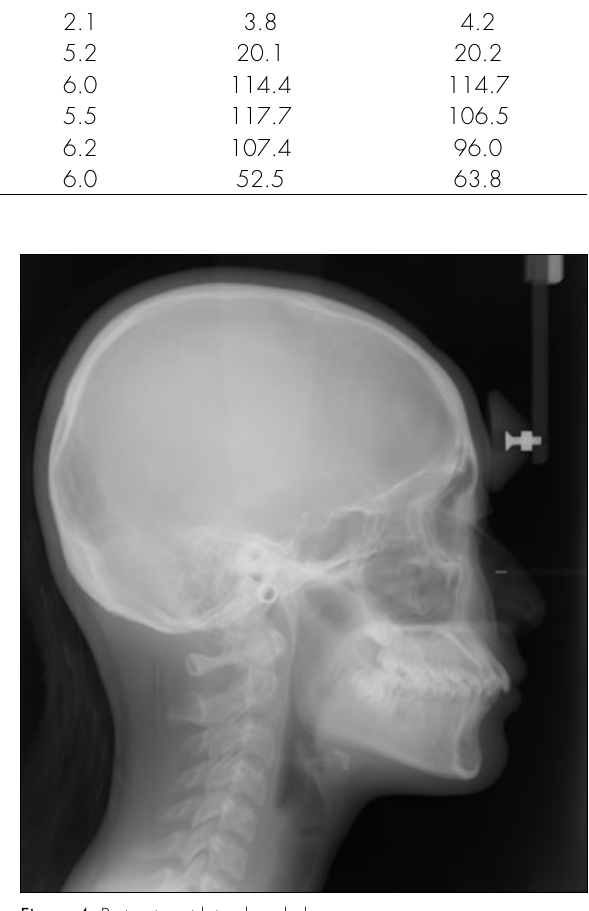
Figure 4. Pretreatment lateral cephalogram.